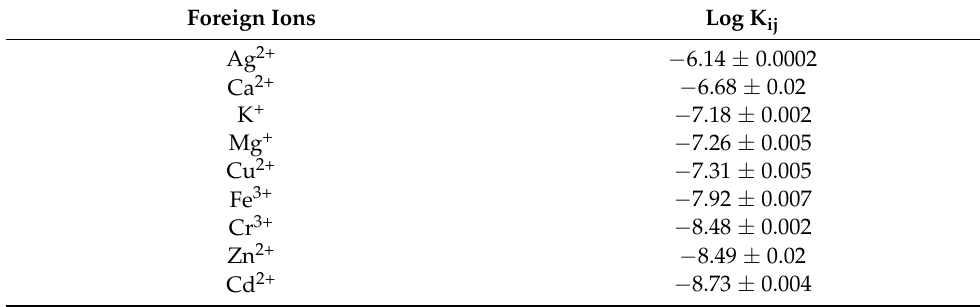
Table 6. Selectivity coefficient of the Pb 2+ ISE against various foreign